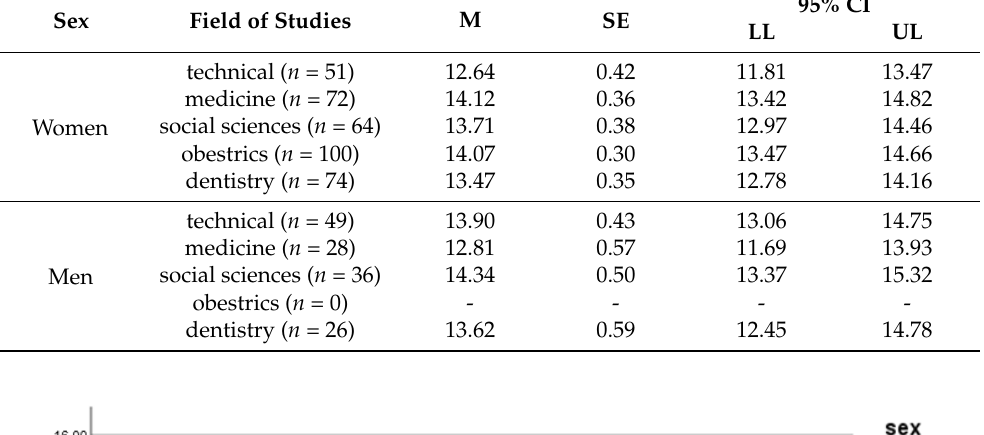
Table 4. Descriptive statistics for psychological health domain with regard to sex and field of studies.